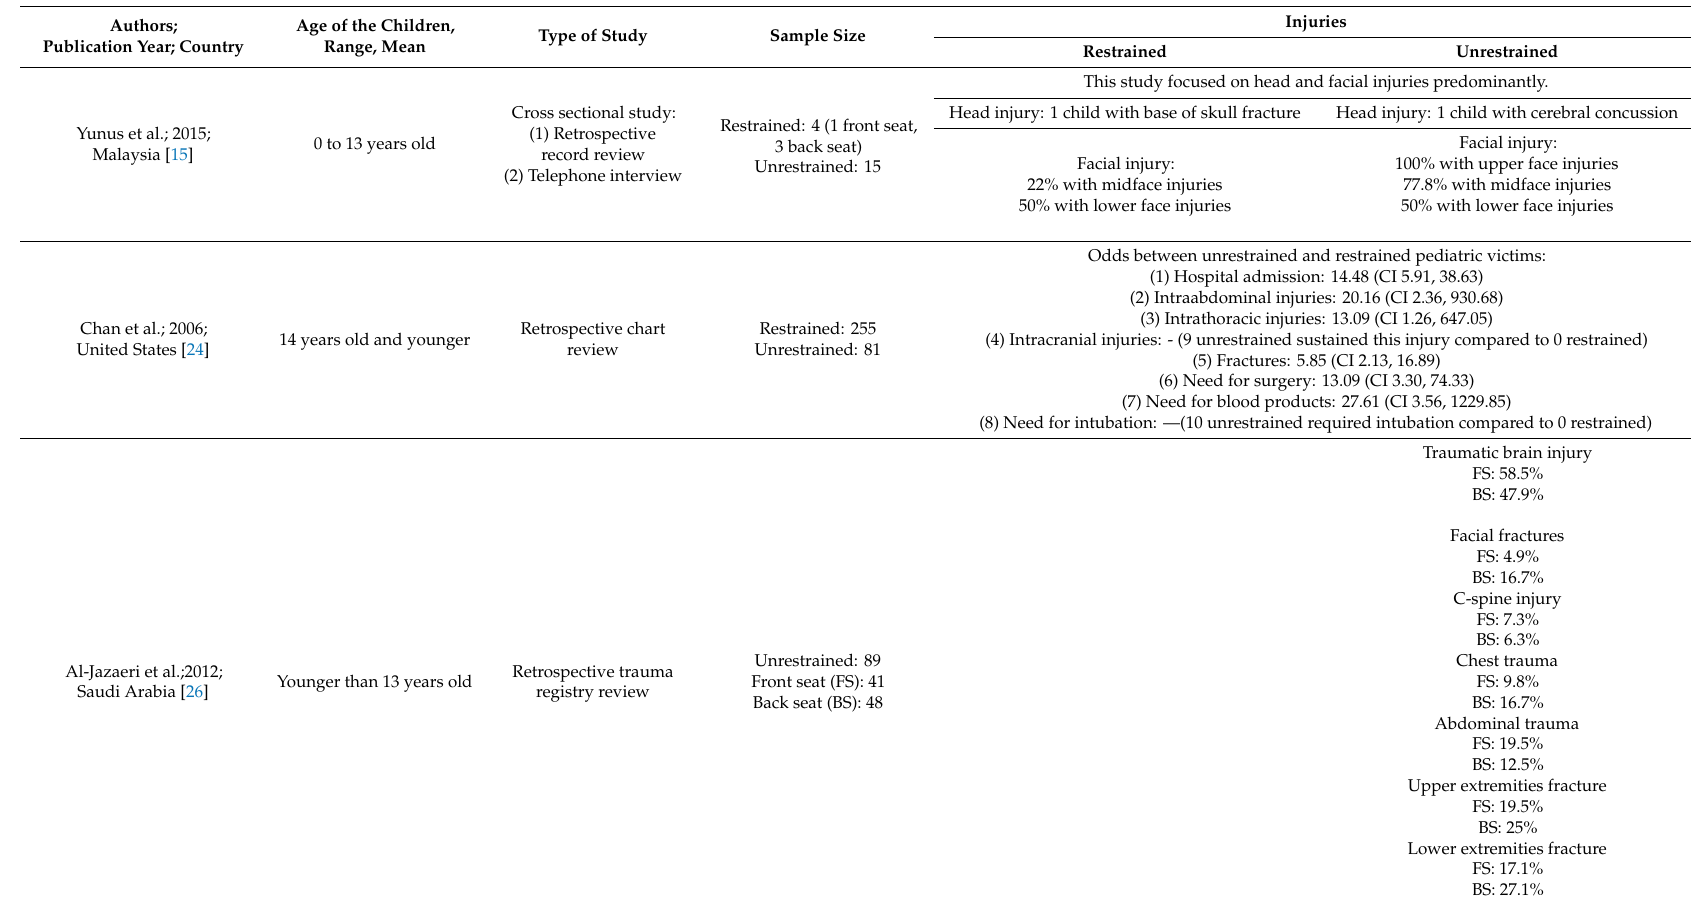
Table 2. Injuries sustained by restrained versus unrestrained